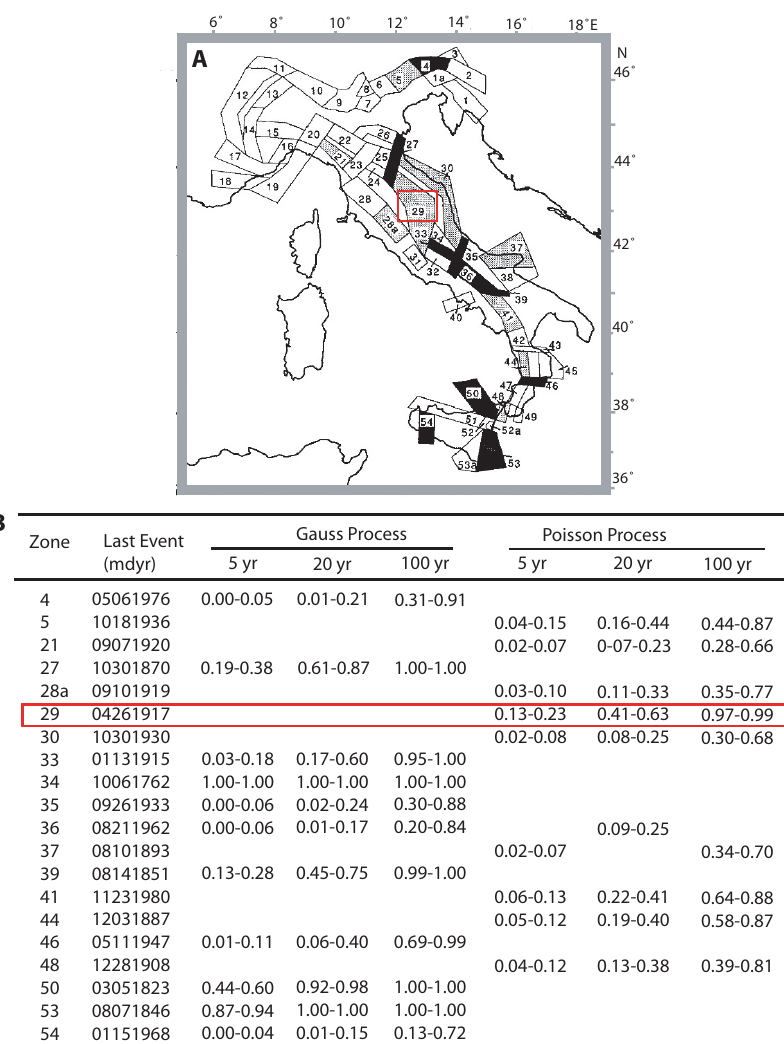
Fig. 1. Boschi et al.’s (1995) forecasts. A) Map of the regionalization used. B) The probabilities estimated for M 5.9+ at different forecasting time windows (5, 20, and 100 years) are reported; the intervals represent the 68% confidence intervals. The red boxes mark the region where Umbria-Marche earthquakes